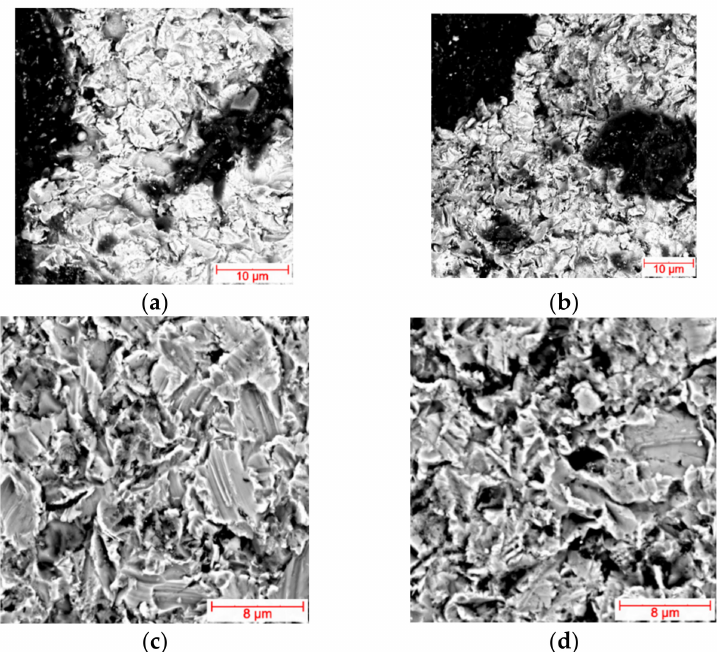
Figure 11. The SEM micrographs of craters surface after erosion test: ( a ) EN-GJS-350-22, impingement angle 30 ◦ ; ( b ) EN-GJS-350-22, impingement angle 90 ◦ ; ( c ) the representative laser-alloyed surface layer, impingement angle 30 ◦ ; ( d ) the representative laser-alloyed surface layer, impingement angle 90 ◦